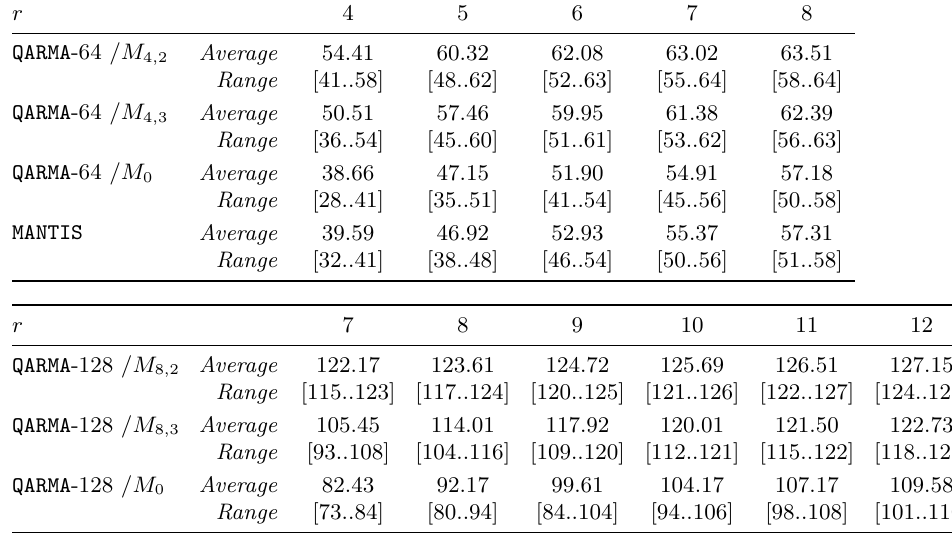
Table 7: Average and Ranges for the Lower Bounds on the Dimensions of Invariant Subspaces of QARMA and MANTIS , Comparing Different Diffusion Matrices